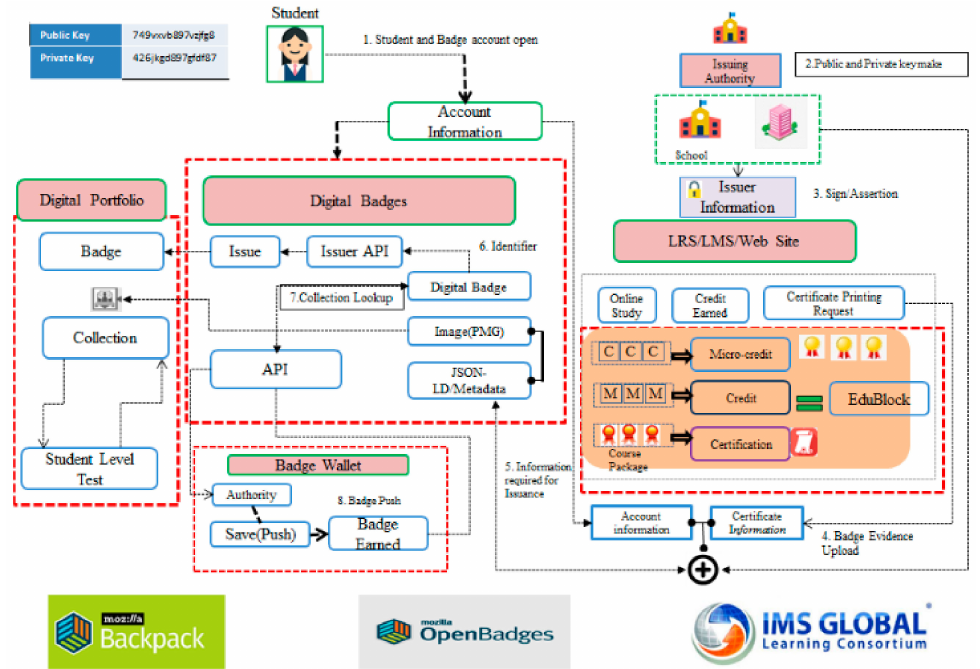
Figure 4. Control flows on digital badge of our system implementation.